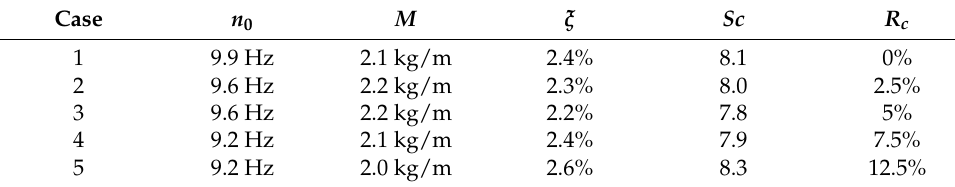
The generalized mass ( M ) and Scruton number ( Sc ) can be expressed by Equations (1) and (2), respectively.